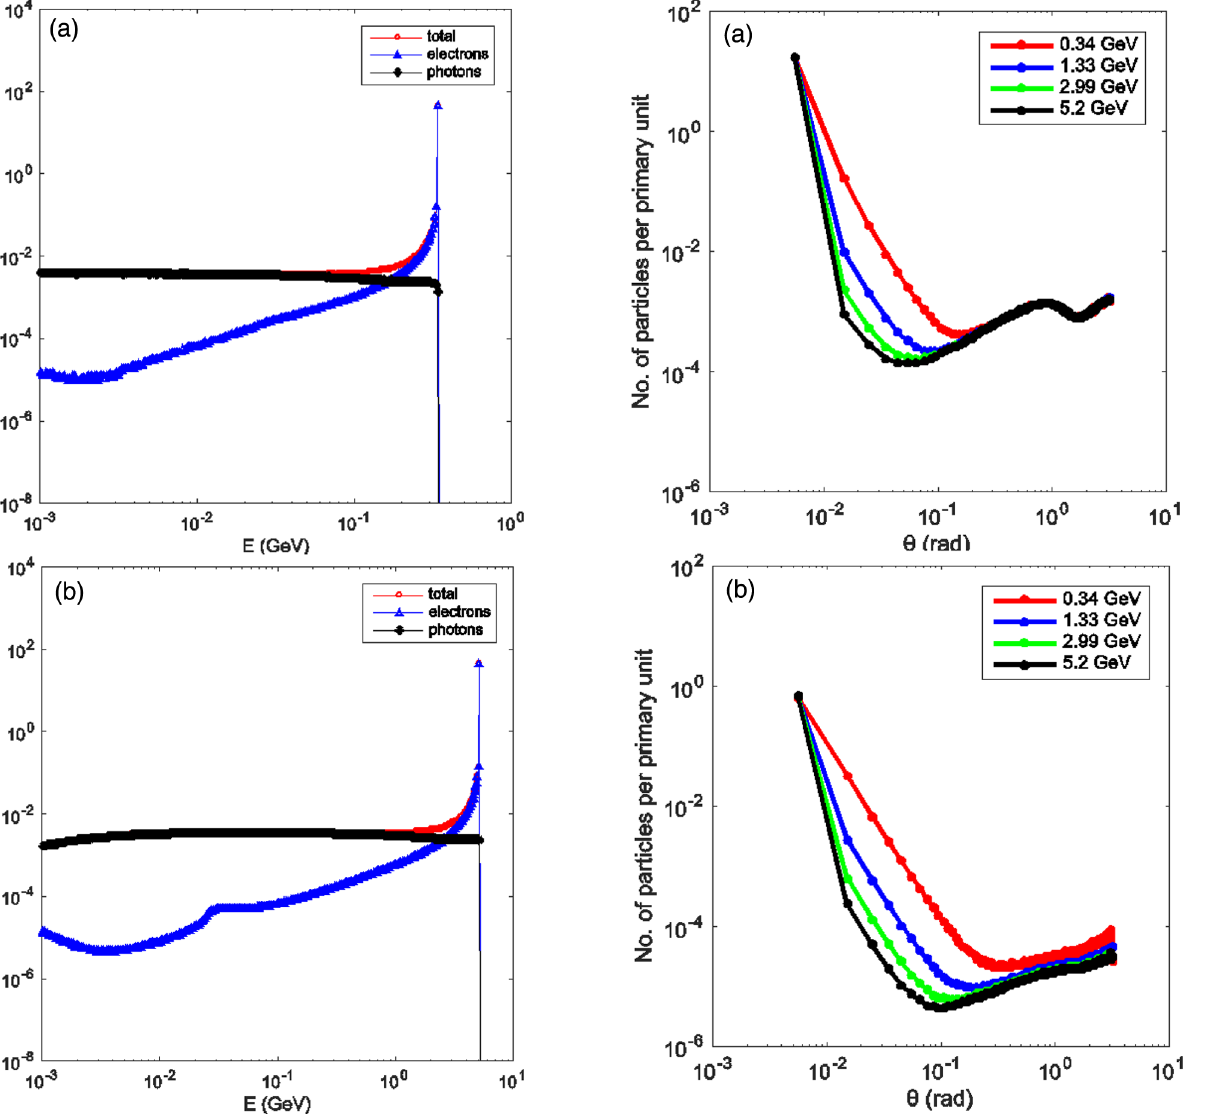
FIG. 7. Energy distribution of the main components of the particle shower forward emitted in the polar angle 0 − π = 16 rad by an electron beam with energy 0.340 (a) and 5.2 (b) GeV colliding onto a 13 μ m tungsten wire.